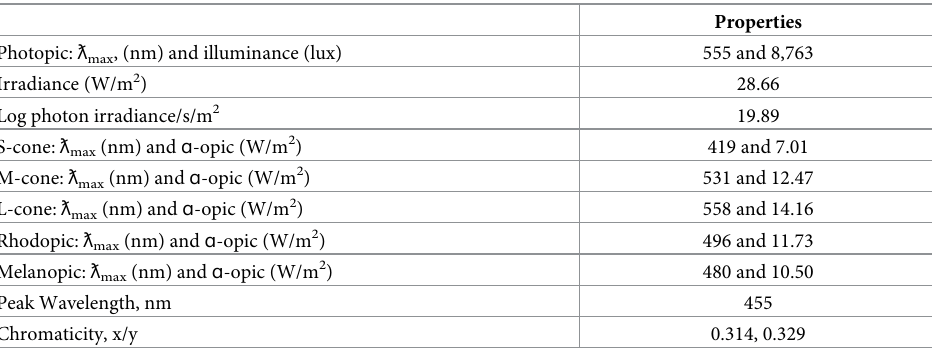
Table 1. Aurora LightPad Mini characteristics.